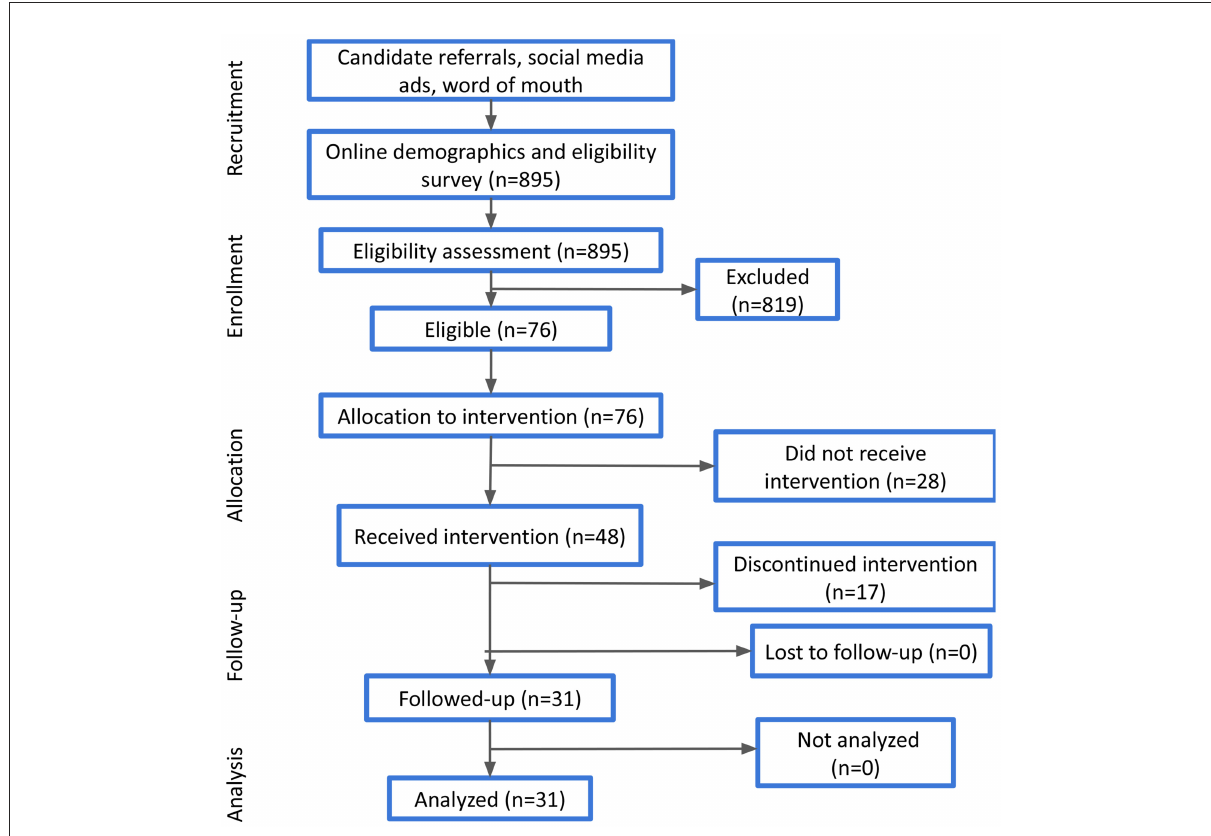
FIGURE1 Overview of the participant screening and onboarding